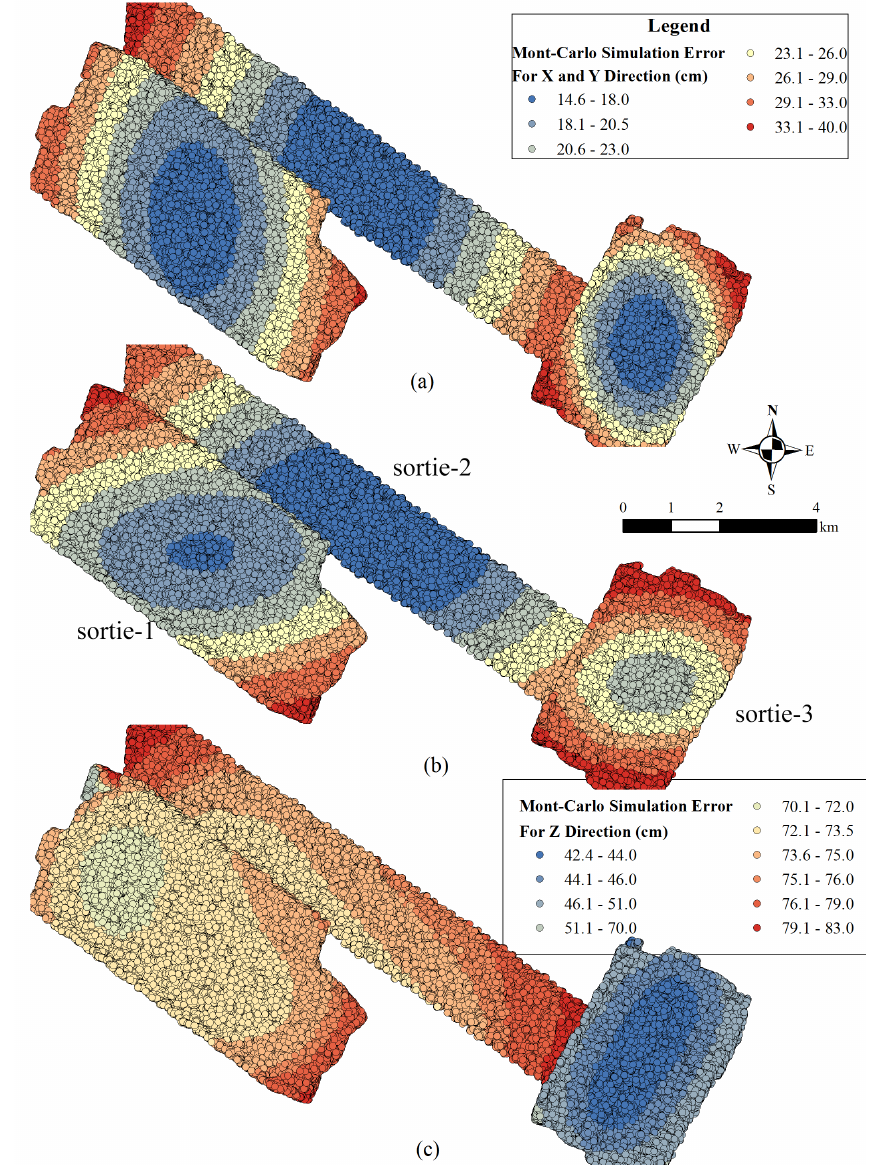
Figure 9. The 3D precision map of sparse point clouds through alignment optimization in Agisoft R (cid:13) PhotoScan, based on Monte Carlo simulations: ( a ) X , ( b ) Y , and ( c ) Z dimensions. The standard deviation of perturbation added into the original POS records is 1.37 m for GPS position and 0.24 ◦ for IMU orientation, as summarized in Table 2. The colour ramps for ( a ) and ( b ) are identical, whereas ( c ) possesses its own. Please refer to James et al. [36] for technical details of evaluation